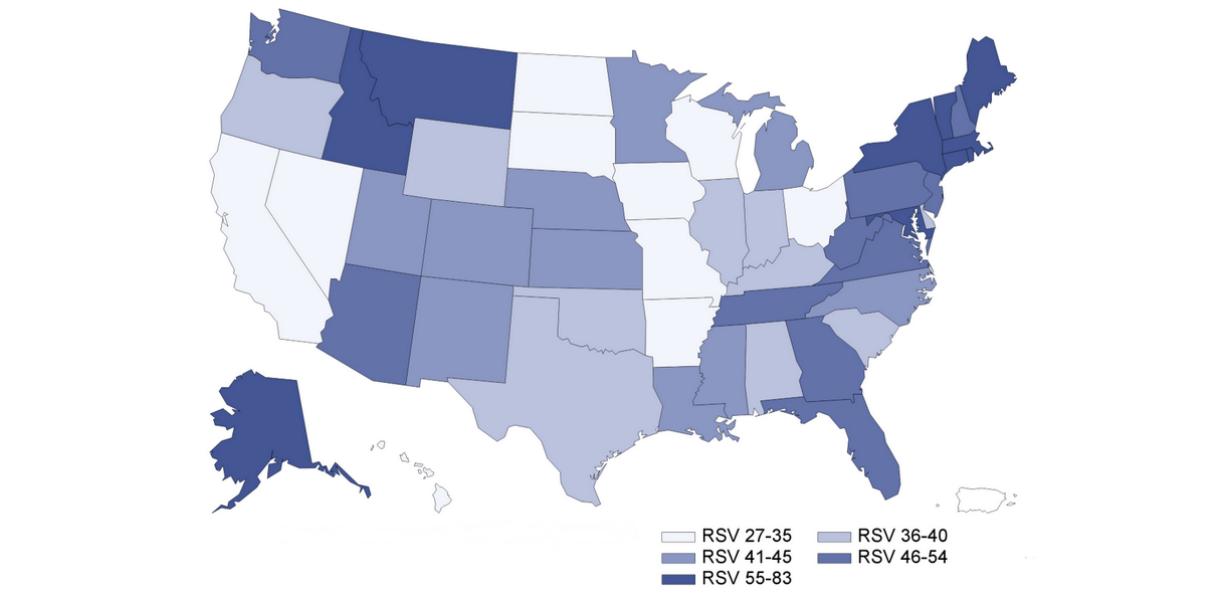
Figure 2. Population interest in telehealth by US state. RSV: relative search